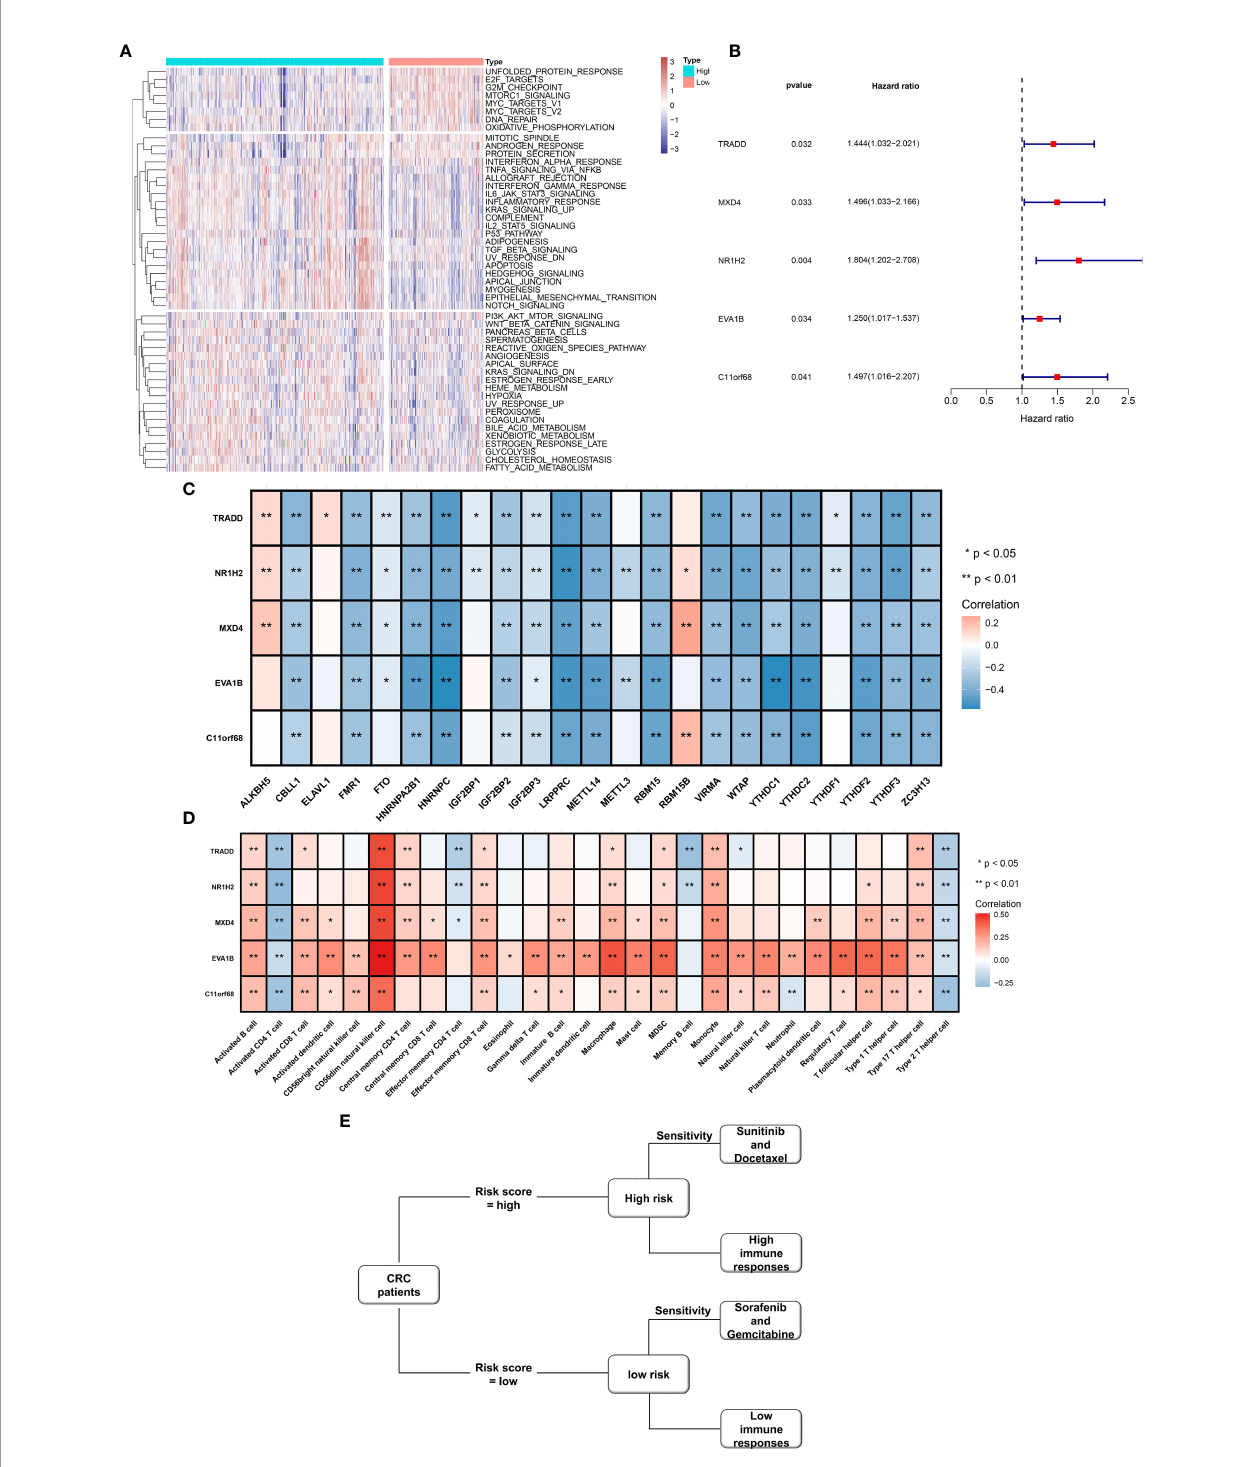
FIGURE 10 | Molecular mechanisms involving EVA1B-derived genomic signature as well as prognostic value of EVA1B-derived genes and their interaction with m 6 A regulators and immune cell in fi ltration in CRC. (A) Heatmap visualizes the activities of hallmark gene signatures in high- and low-risk subpopulations. (B) Forest diagram depicts the interaction of EVA1B-derived genes with CRC clinical outcomes in accordance with univariate-Cox regression models. (C) Heatmap depicts the association of EVA1B-derived genes with m 6 A regulators across CRC specimens. (D) Heatmap visualizes the interaction of EVA1B-derived genes with immune cell in fi ltration in CRC. (E) Association among drug sensitivity, predictive immune responses, and risk status of CRC individuals. (* p < 0.05; ** p <